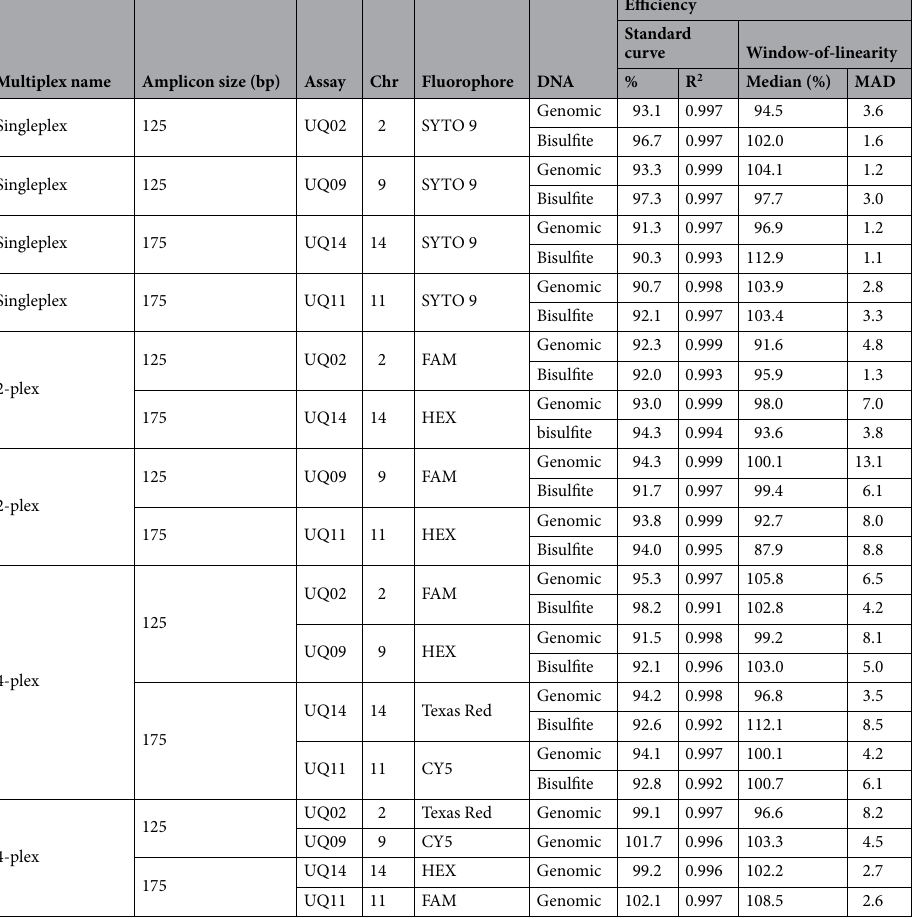
Table 1. Universal 4-plex qPCR amplification